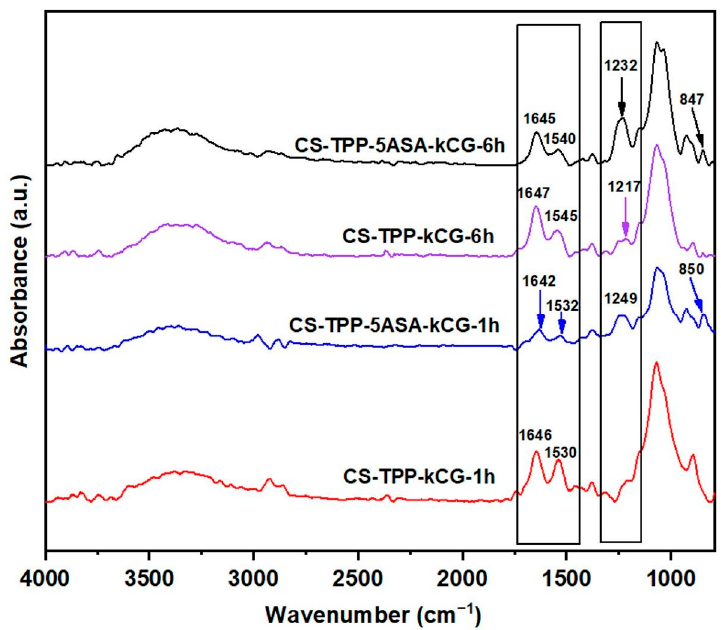
Figure 4. FT-IR spectra of blank, loaded CS-TPP-kCG-1h and CS-TPP-kCG-6h.